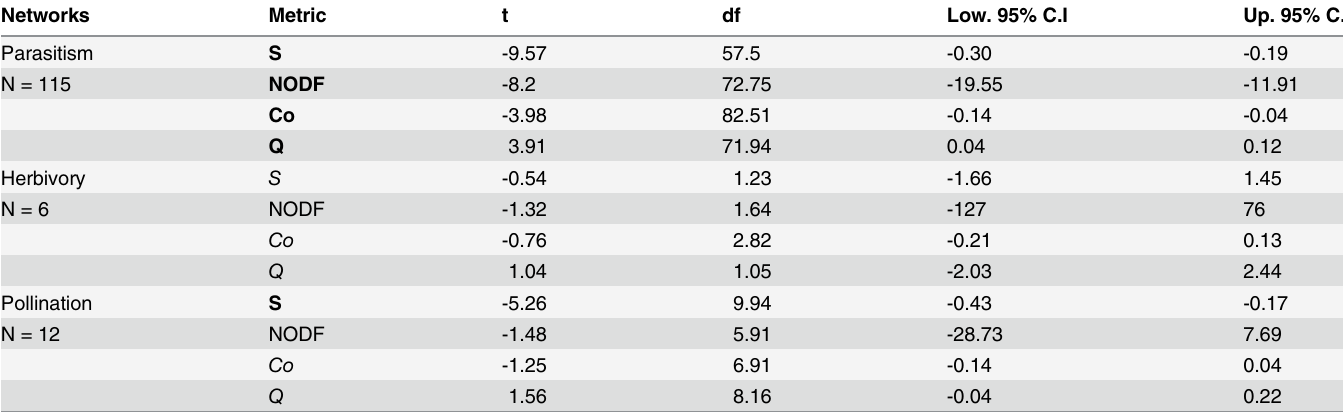
Table 2. Analysis of the results presented in Fig 2. We used a two-sample t-test to determine differences from chance expectations for networks with either less, equal, or more strategy diversity. We observe that all metrics are different from chance expectations for parasitism networks, but not for other interaction types (although our failure to report an effect is most likely due to the small sample size, as indicated by certain large confidence intervals).